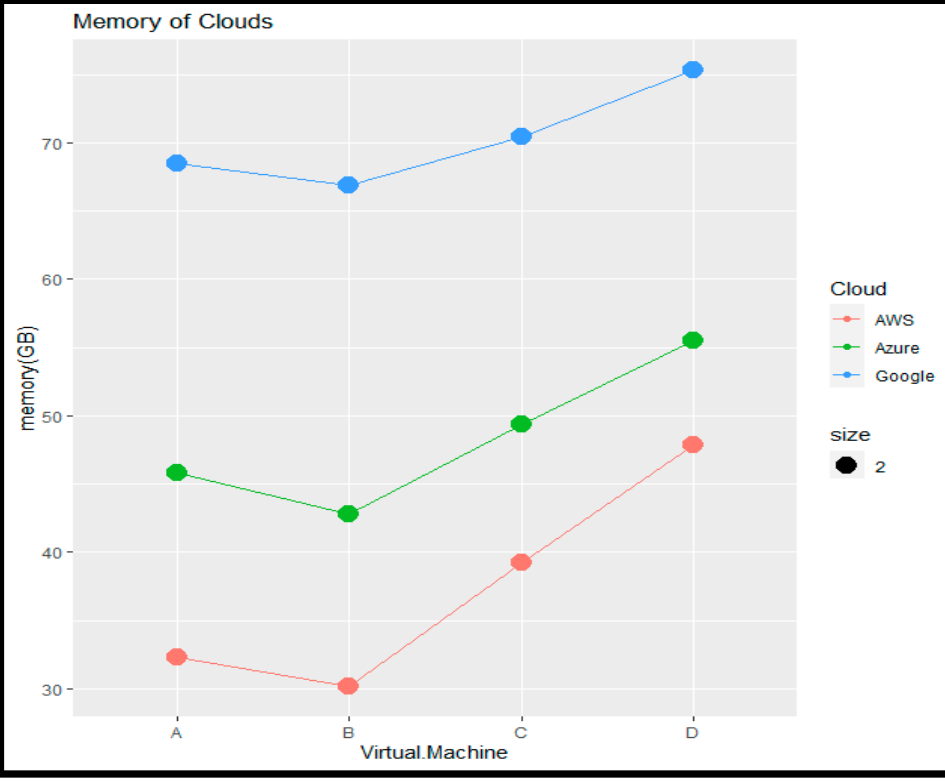
Figure 10. Memory (GB) for different VMs on clouds .